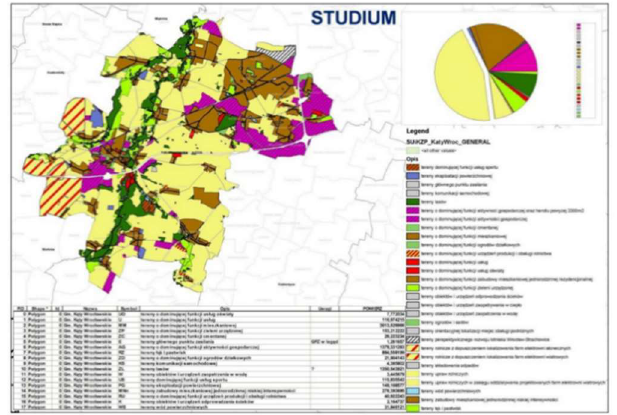
Figure 11. Area of SUiKZP residential areas = 3296 ha (18.7% of the municipality area). Resources: P. Malczewski, Institute of Territorial Development in